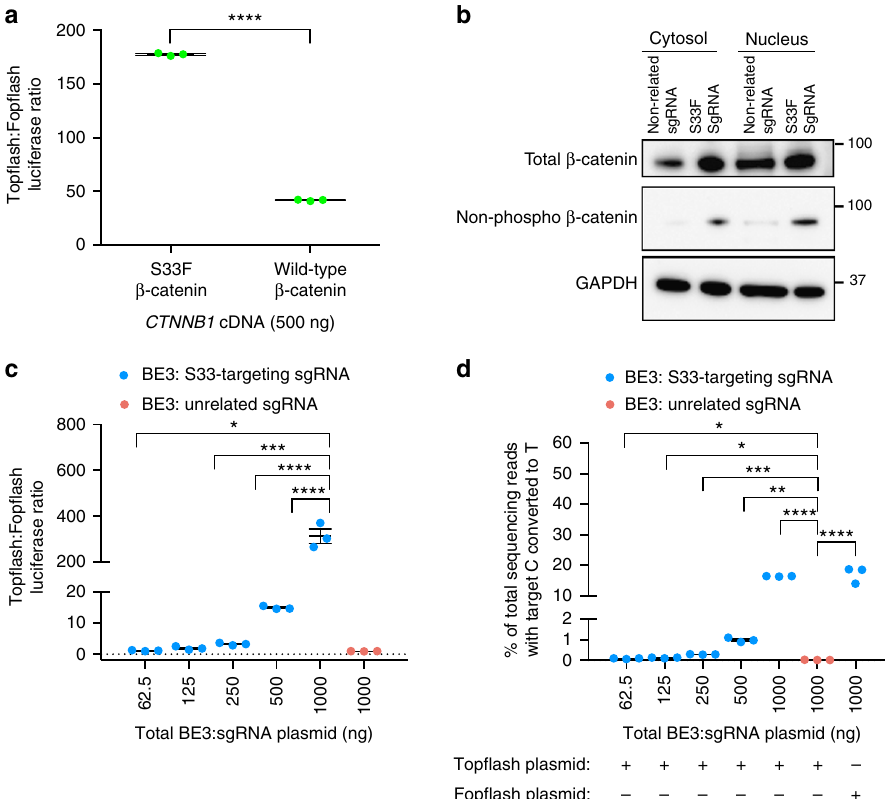
Fig. 2 Biological outcomes associated with base editing S33F in β -catenin in human cells. a HEK293T cells were transfected with plasmids encoding Top fl ash ( β -catenin-responsive fi re fl y luciferase reporter) or Fop fl ash (mutant form of Top fl ash that cannot be activated by β -catenin) and mutant S33F β - catenin or wild-type (Ser 33) β -catenin. Wnt signaling was measured by the ratio of Top fl ash:Fop fl ash luciferase activity. b Cytosolic and nuclear extracts of HEK293T cells treated with base editor and S33-targeting sgRNA or unrelated sgRNA were subjected to western blot analysis for total β -catenin or non- phosphorylated β -catenin (Ser33/Ser37/Thr41). Each blot represents one antibody. GAPDH was used as a loading control. c HEK293T cells were transfected with plasmids encoding the Top fl ash or Fop fl ash reporters, base editor, and S33F or unrelated control sgRNA. The Top fl ash:Fop fl ash luciferase ratio for BE3 + S33-targeting sgRNA (blue) and BE3 + unrelated sgRNA (red) are shown. d Percent C-to-T conversion at the target Ser 33 codon, which results in the S33F mutation in β -catenin, assayed by HTS. Values and error bars re fl ect mean ± S.E.M. of three biological replicates performed on